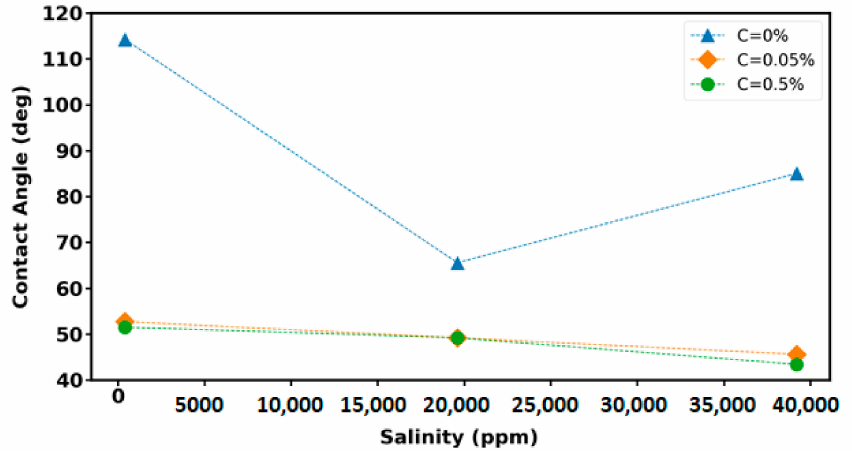
Figure 11. Contact angle variations as a function of base fluid salinity and nanoparticle